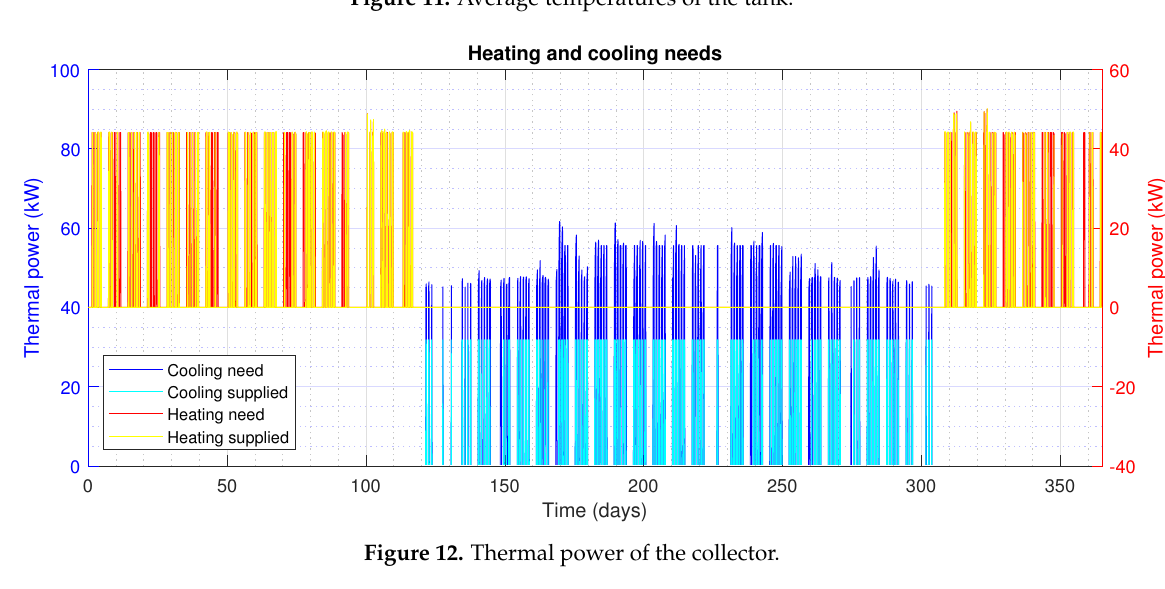
Figure 11. Average temperatures of the tank.